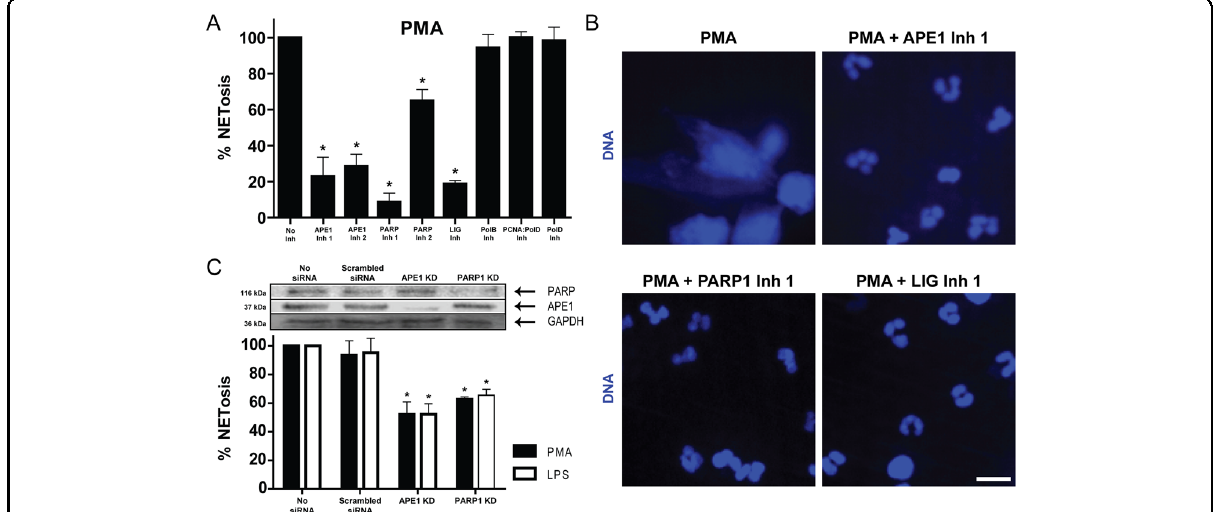
Fig. 3 Inhibition of early steps, but not late steps, of DNA repair suppresses NETosis induced by PMA and LPS. A DNA release from neutrophils following media (-ve control) or PMA (25 nM) was measured using the SYTOX Green plate reader assay. Cells were preincubated with BER inhibitors (APE inh 1, CRT0044876 (125 μ M); APE inh 2, APE1 Inhibitor III (50 μ M); PARP1 inh 1, BSI201 (100 μ M); PARP inh 2, PJ34 (50 μ M); LIG inh, L189 (100 μ M); Pol β inh, AM-TS23 (25 μ M); PCNA:Pol δ inh, T2AA (25 μ M) or Pol δ inh, Aphidicolin (50 μ M)) for 1 h prior to PMA treatment ( n = 3; * p <